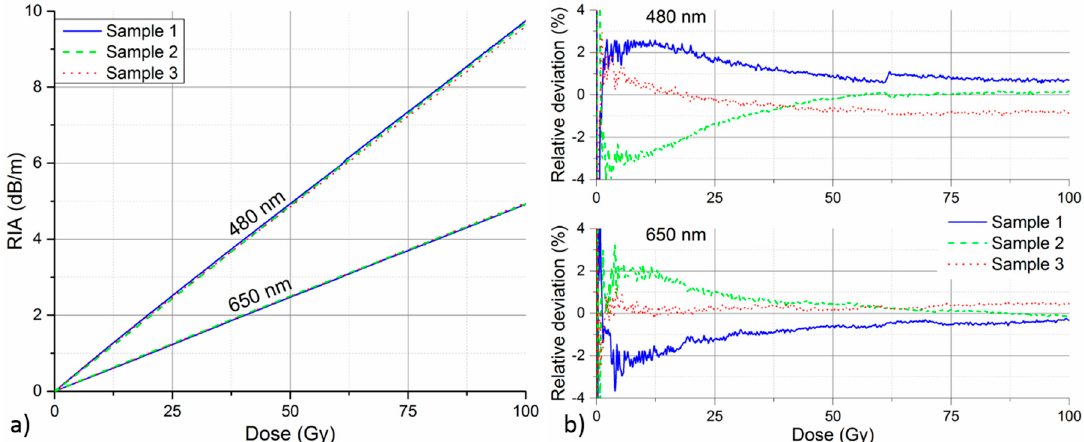
Figure 5. Repeatability of RIA measurement with irradiation of three different samples under the same conditions (room temperature, 150 Gy/h). ( a ) RIA growth curves at two selected wavelengths. ( b ) Relative deviation of the individual RIA curves from the respective mean values at given wavelengths.